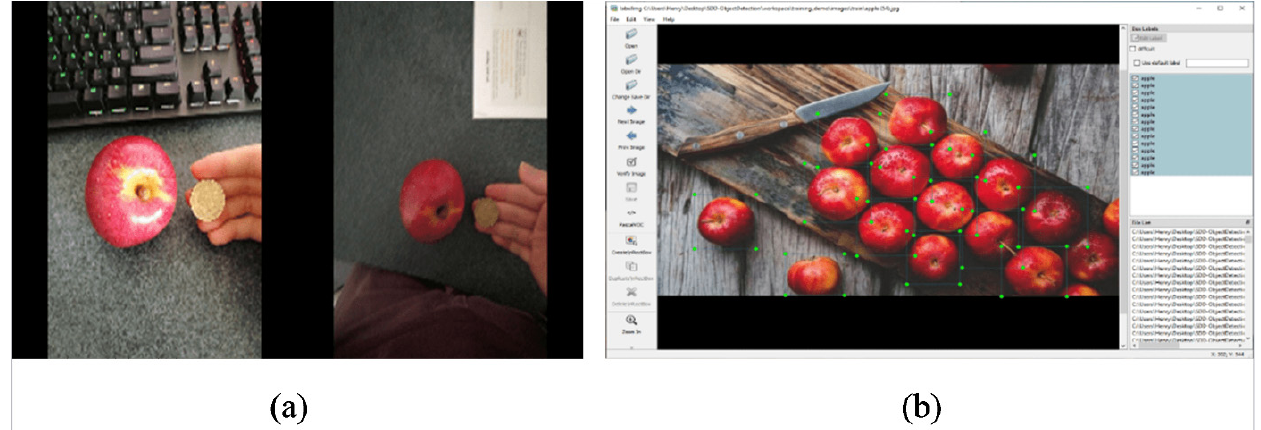
Figure 4. ( a ) Dataset image examples, ( b ) labelImg user interface. Table 1. Details of test and training dataset.